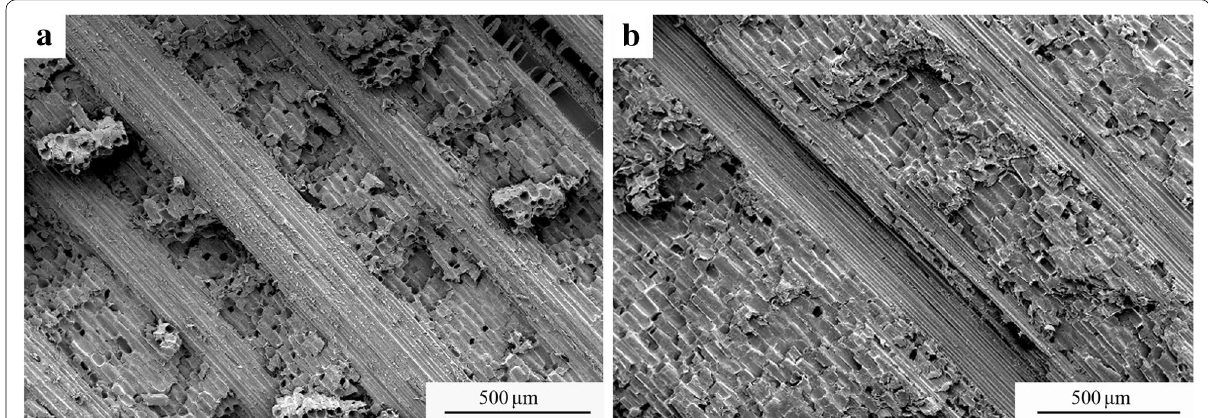
Fig. 5 Morphology of fracture bamboo: a the outer side, b the inner